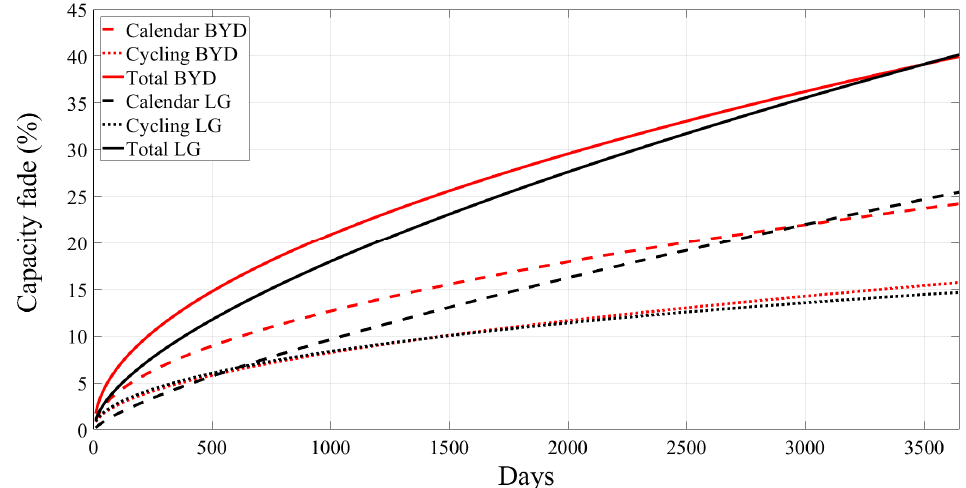
Figure 4. Degradation evolution throughout 10 years under warranty conditions for the two commercial Li ‐ ion battery packs analyzed in this work.